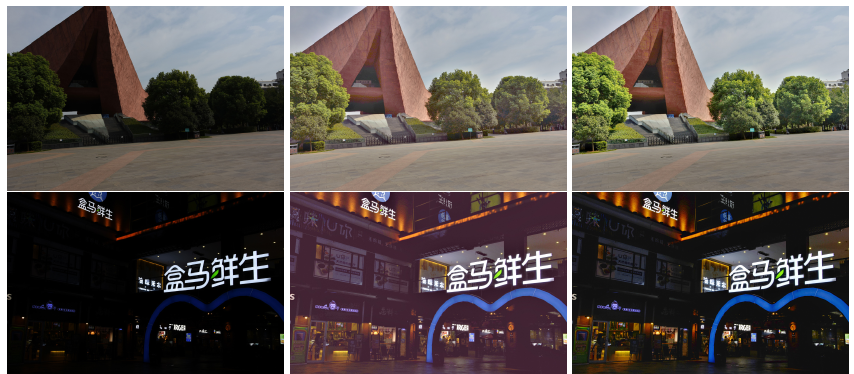
Figure 11. Compare the brightened image (the second row of images is a supermarket in China) by using inaccurate camera response functions (CRFs) and accurate CRFs. The first column shows input images; the second column shows brightened images by using inaccurate CRFs; the last column shows brightened images by using accurate